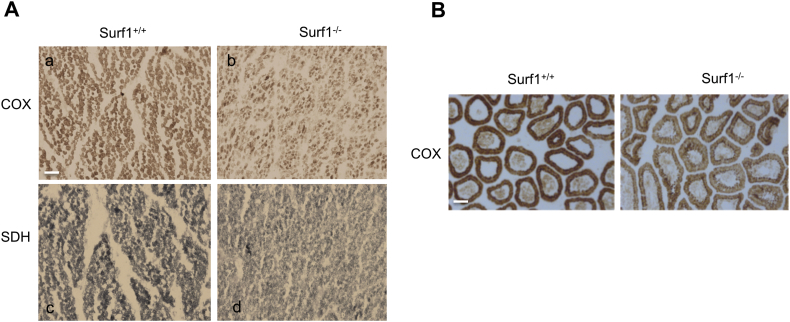
Histochemical findings in swine SURF1−/− model.A) COX (a, b) and SDH (c, d) staining of quadriceps from newborn SURF1+/+ and SURF1−/− piglets. Note the paler colour in both stainings in SURF1−/− samples, suggesting a general reduction of MRC activities.B) COX staining of jejunum villi from newborn SURF1+/+ and SURF1−/− piglets. Note the reduction in COX staining in the SURF1−/− sample.